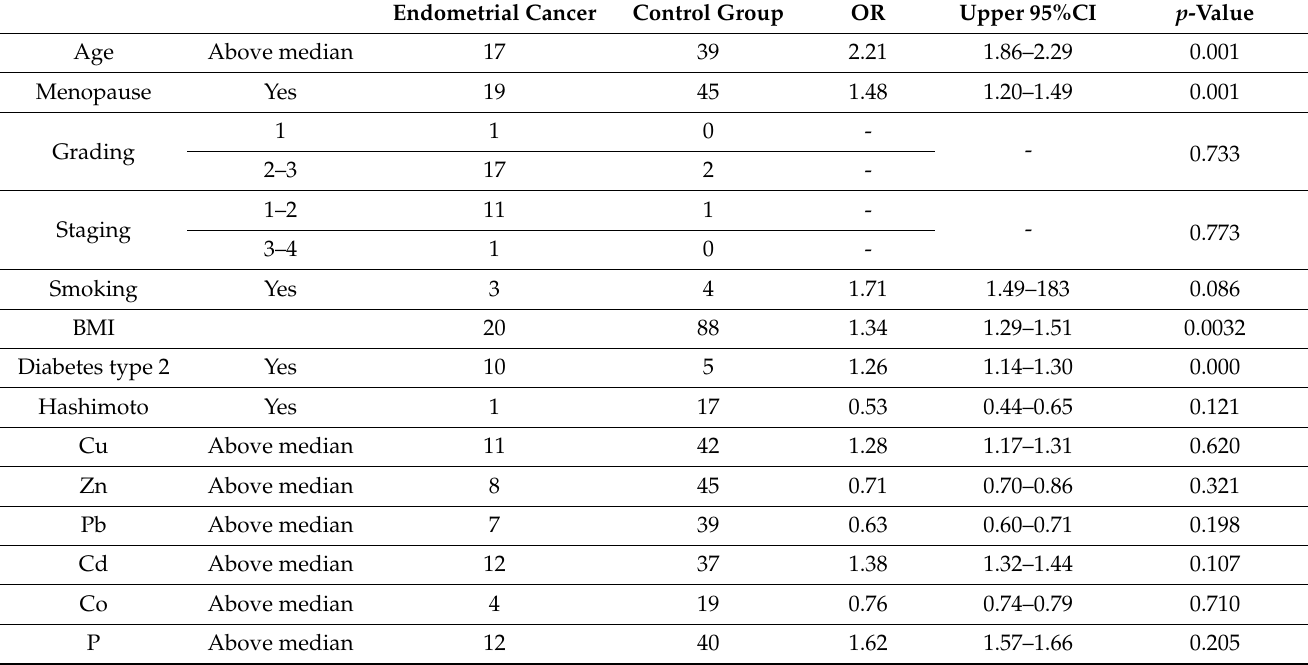
Table 5. Univariate logistic regression model.